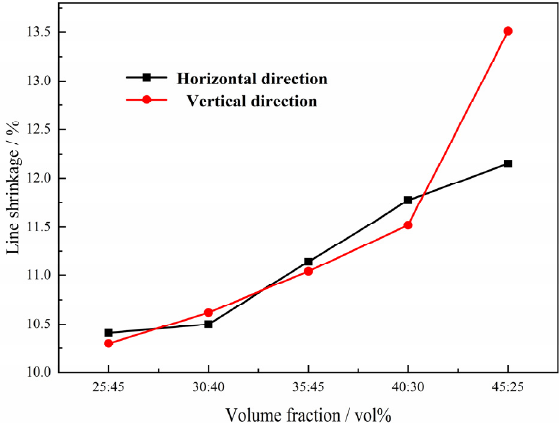
Figure 11. Relationship between line shrinkage and fraction of the magnesium powder when the volume fraction of the magnesium particles and the magnesium powders is fixed at 70 vol.%.